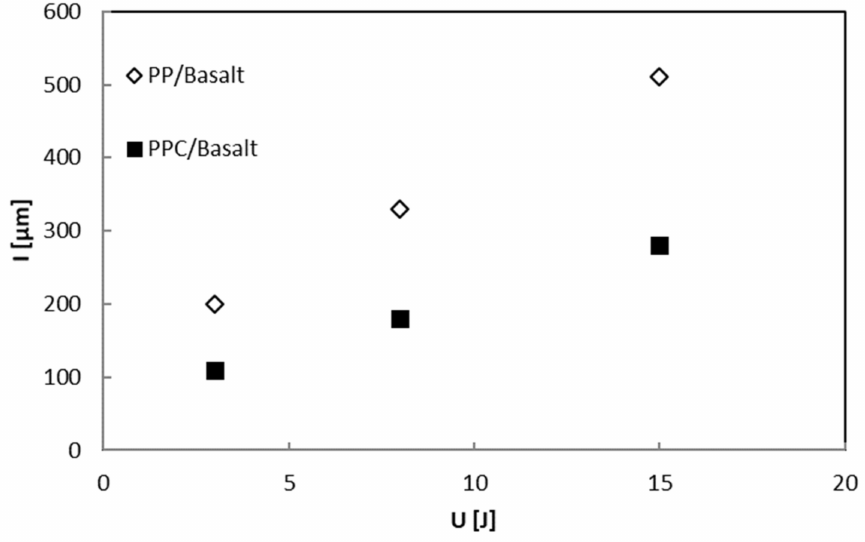
Figure 14. PP / Basalt and PPC / Basalt Indentation depth, I, versus the impact energy,